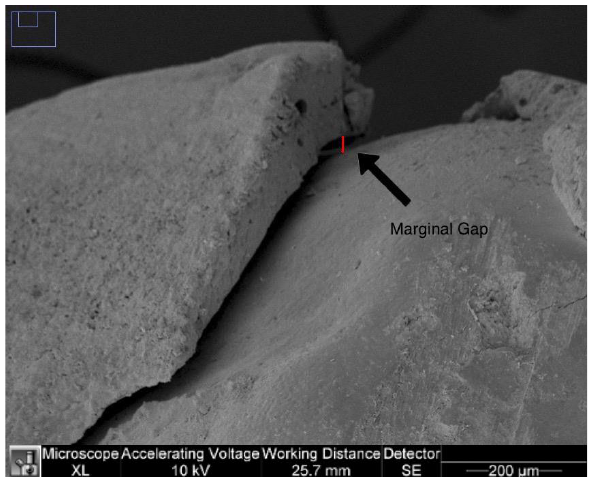
Figure 2. Marginal gap on a 250× image.